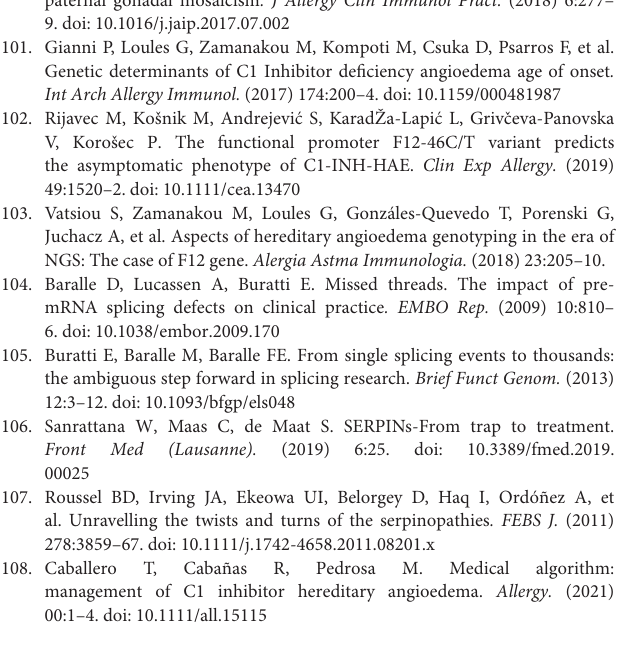
management of C1 inhibitor hereditary angioedema. Allergy.